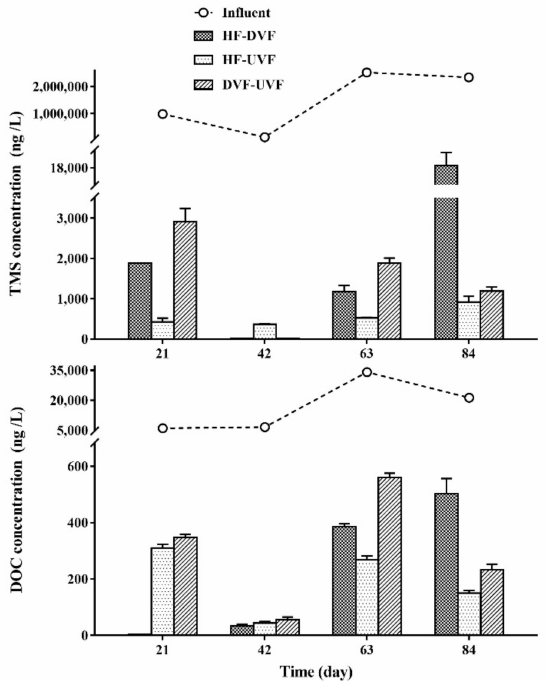
Figure 1. TMS and DOC concentrations in the influent and e ffl uent of di ff erent hybrid constructed wetlands. HF-DVF: horizontal subsurface flow-down-flow vertical subsurface flow CWs; HF-UVF: horizontal subsurface flow-up-flow vertical subsurface flow CWs; DVF-UVF: down-flow vertical subsurface flow-up-flow vertical subsurface flow